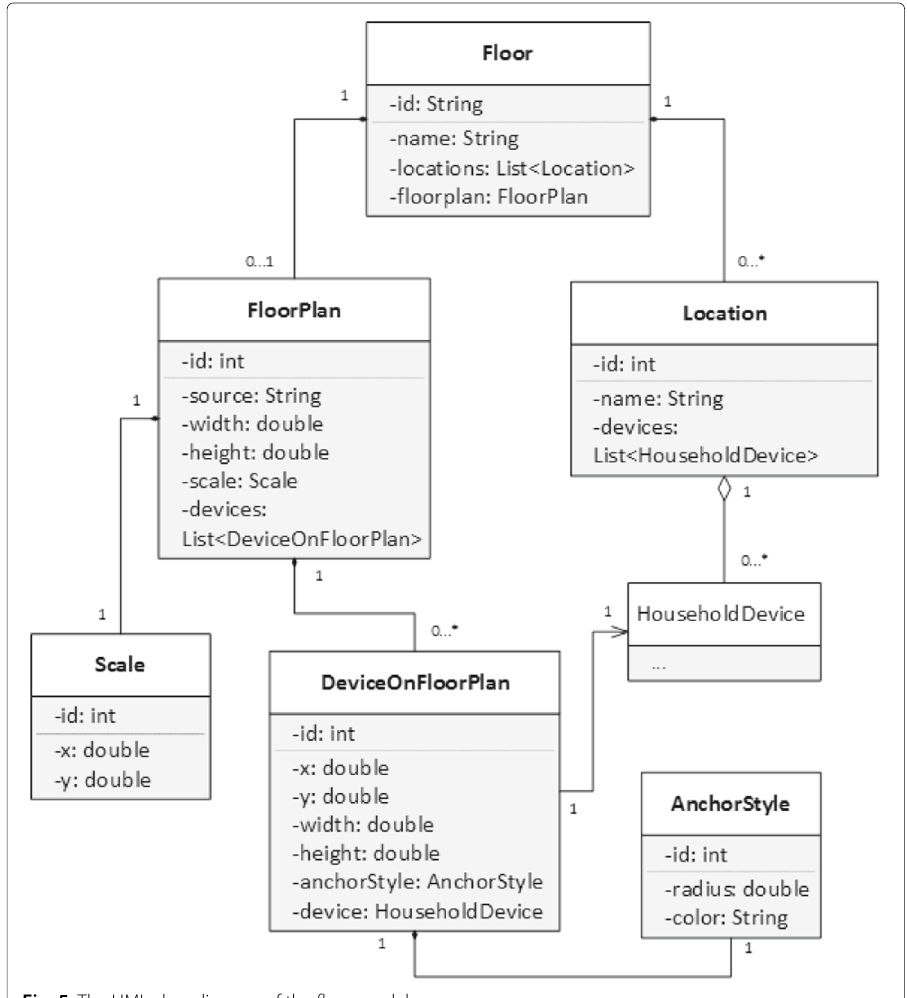
Fig. 5 The UML class diagram of the floor